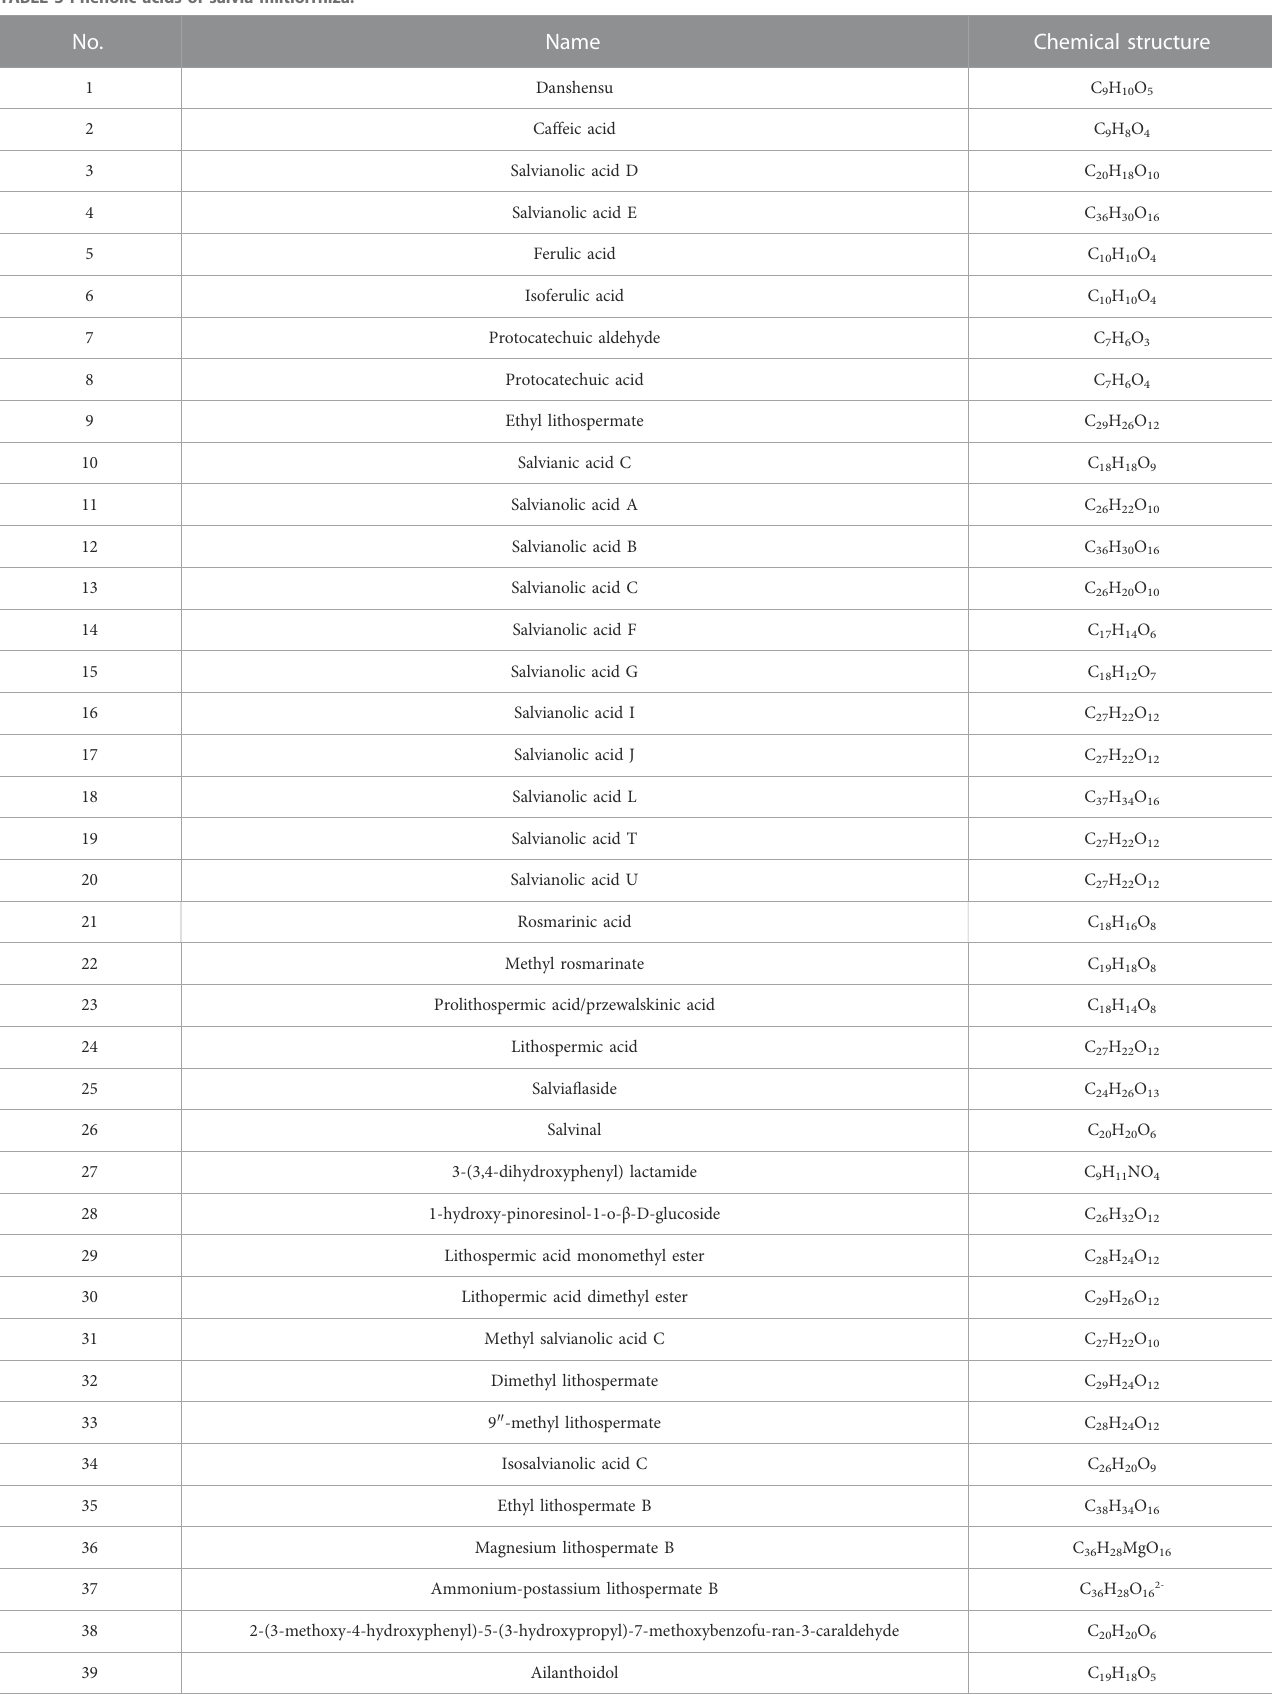
TABLE 3 Phenolic acids of salvia miltiorrhiza.